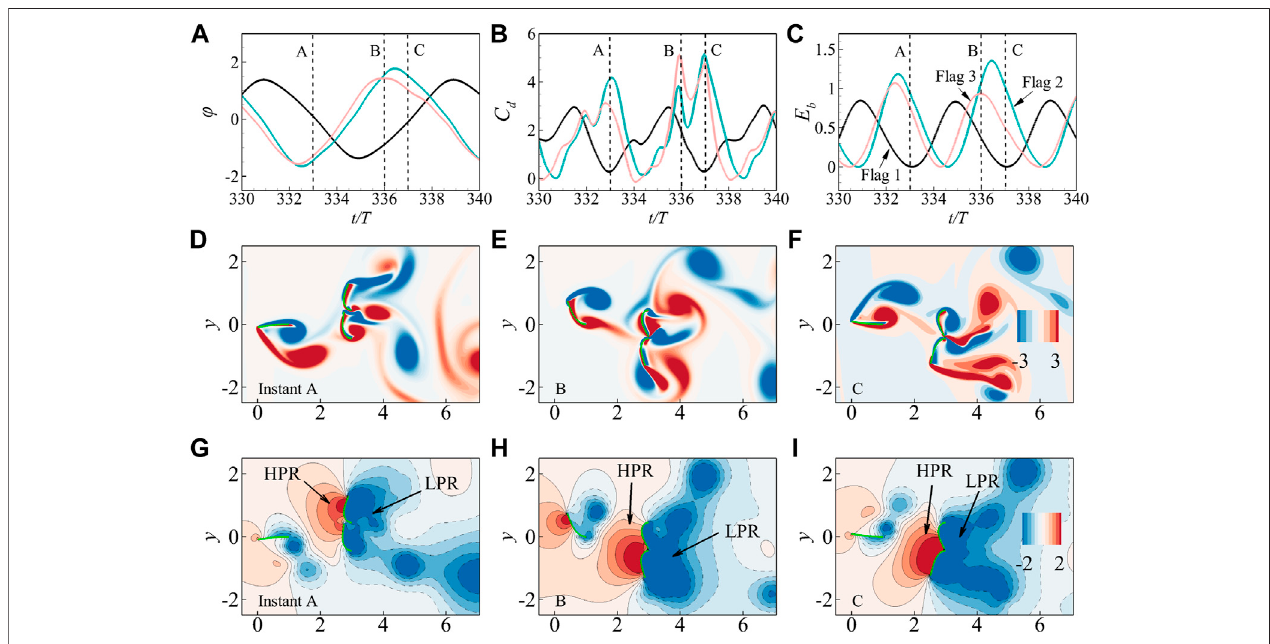
FIGURE 9 | The angle ϕ (A) , instantaneous drag coef fi cient C d (B) and bending energy E b (C) for the case with H =0.9 and G =1 in harvest enhancement region (HER), with the instantaneous vorticity (D,E,F) and pressure (G,H,I) contours for the typical instant A (D,G) , B (E,H) and C (F,I) , which are marked by the dashed lines in (A,B,C) . It is seen that the higher pressure region (HPR) and the lower pressure region (LPR) are marked by the arrows in (G,H,I) .